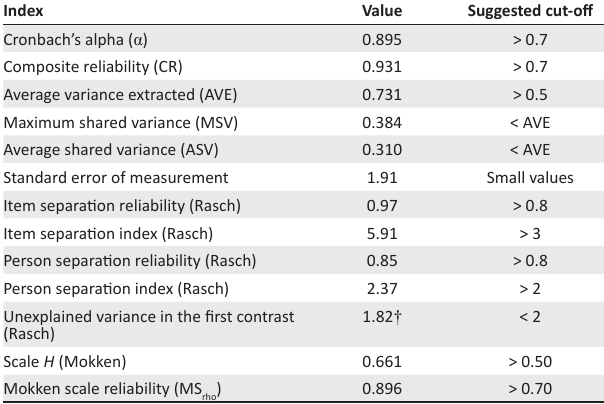
TABLE 4: Classical test theory and item response theory indices for the Satisfaction with Life Scale at the scale level.